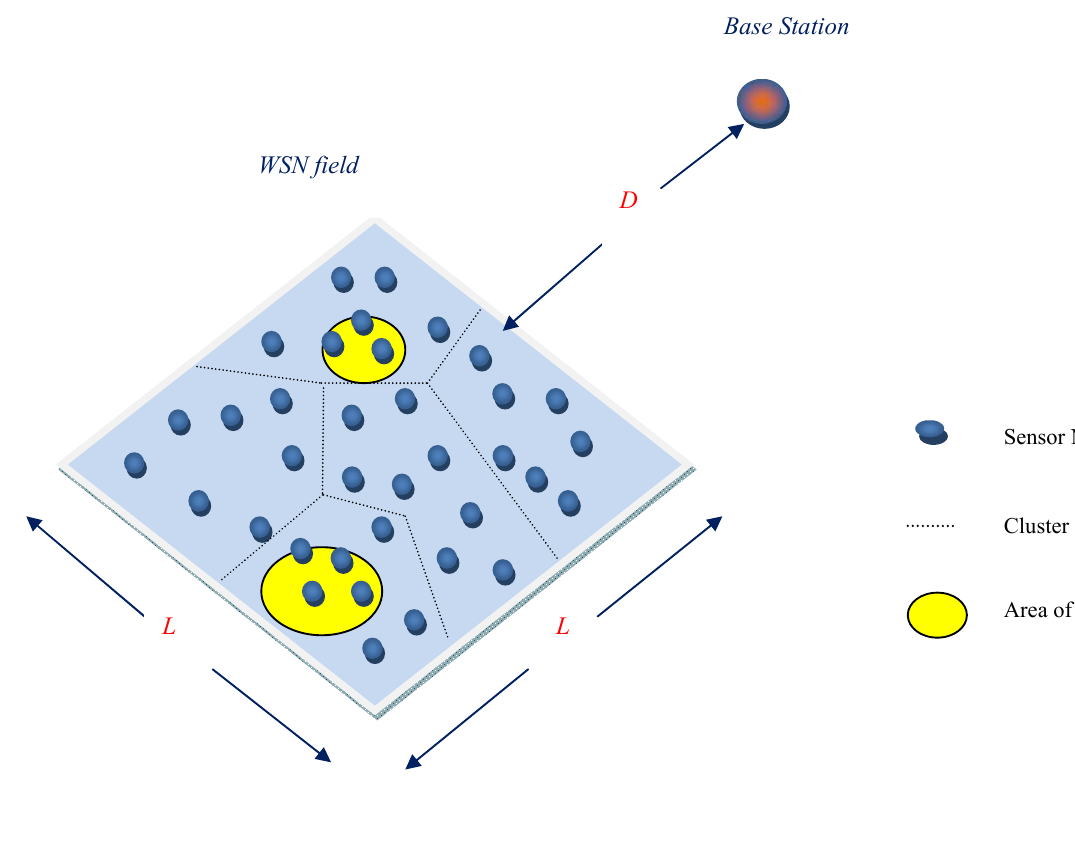
Figure 3. Graphical depiction of the architecture of the WSN scheme